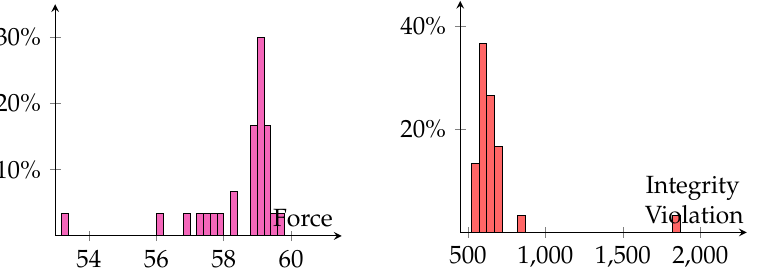
Figure 23. Histograms multi-material of solutions: ( left ) values of the computed force; ( right ) solution integrity